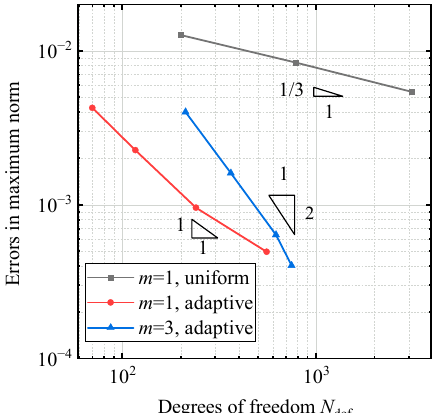
Figure 23. Convergence rates of uniform refinement and adaptive refinement.